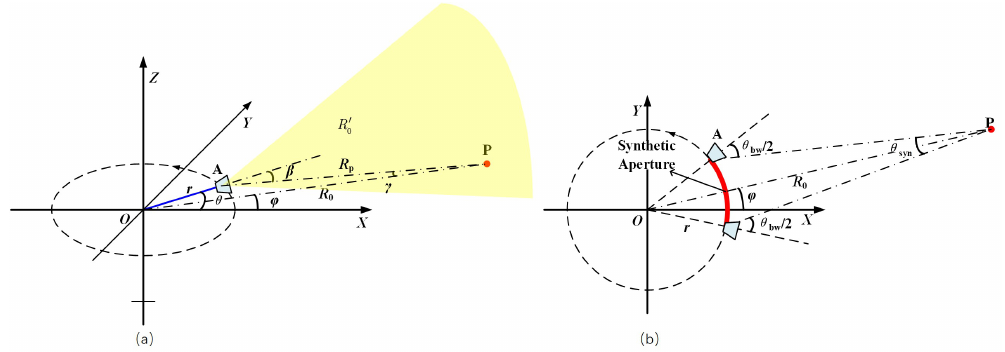
Figure 1. Geometry of arc-scanning synthetic aperture radar (ArcSAR): ( a ) Geometry of ArcSAR. ( b ) Top view of the ArcSAR